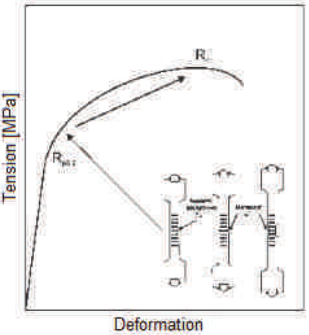
Fig. 6. Schematic presentation of the TRIP multiphase steel extension curve along with the schematics of deformation-induced martensitic transformation